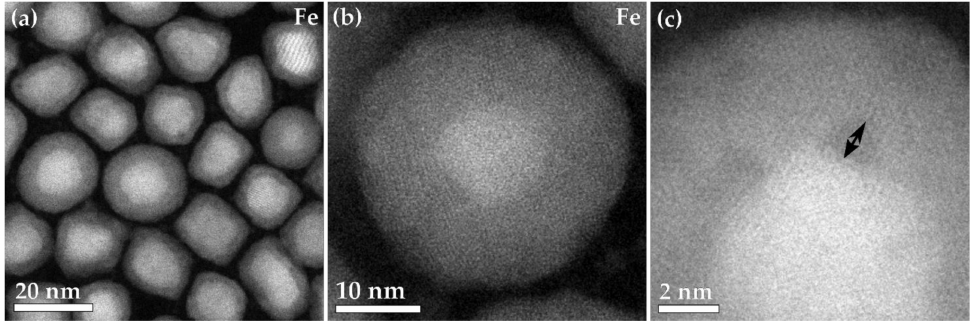
Figure 1. ( a – c ) HAADF-STEM images of the Fe. The higher magnification images show the interface between the core and the oxide shell, with black arrows noting the voids formed.